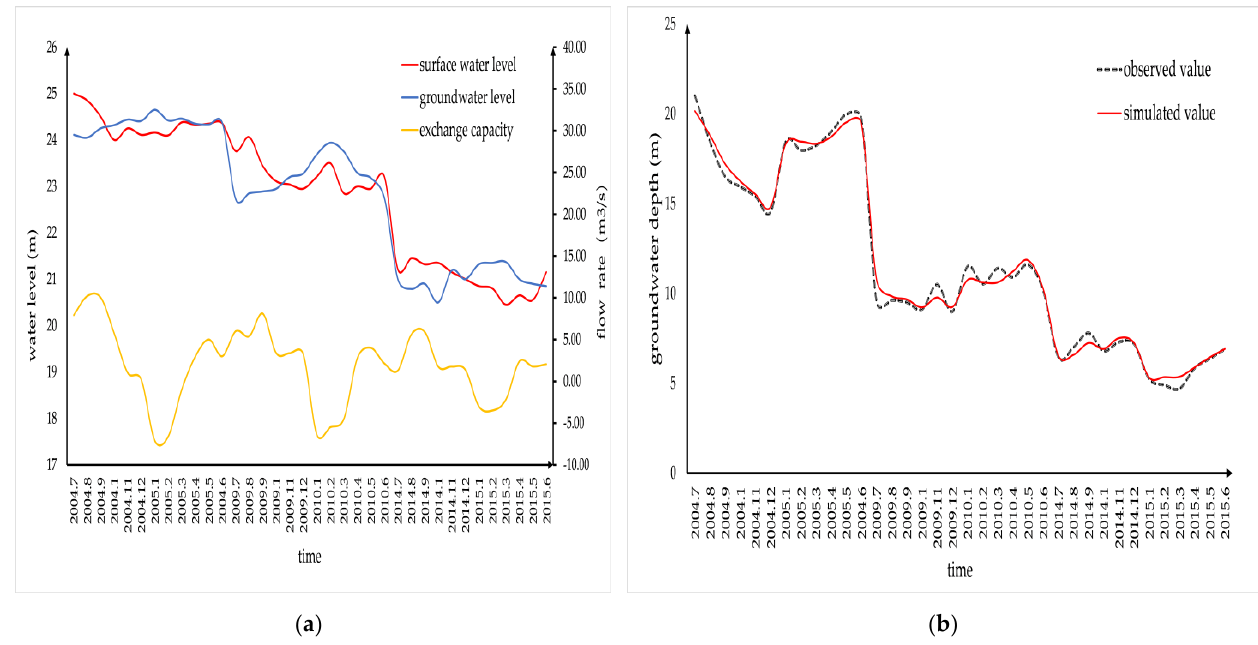
Figure 9. Comparison of WEP-simulated and observed values: ( a ) Comparison of groundwater level and exchange capacity of surface water in Jinan section of Xiaoqing River; and ( b ) comparison of groundwater depth in Jinan section of Xiaoqing River. Table 4. Annual distribution of annual average runoff for each station in Xiaoqing River